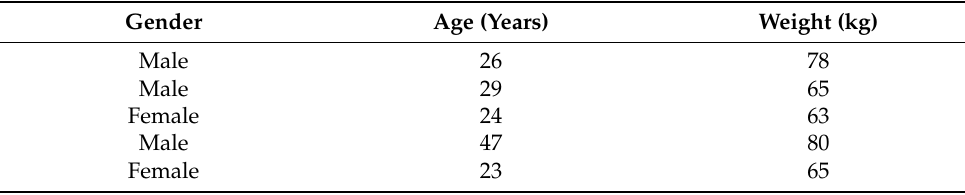
Table 1. Information about the subjects in the static system validation.